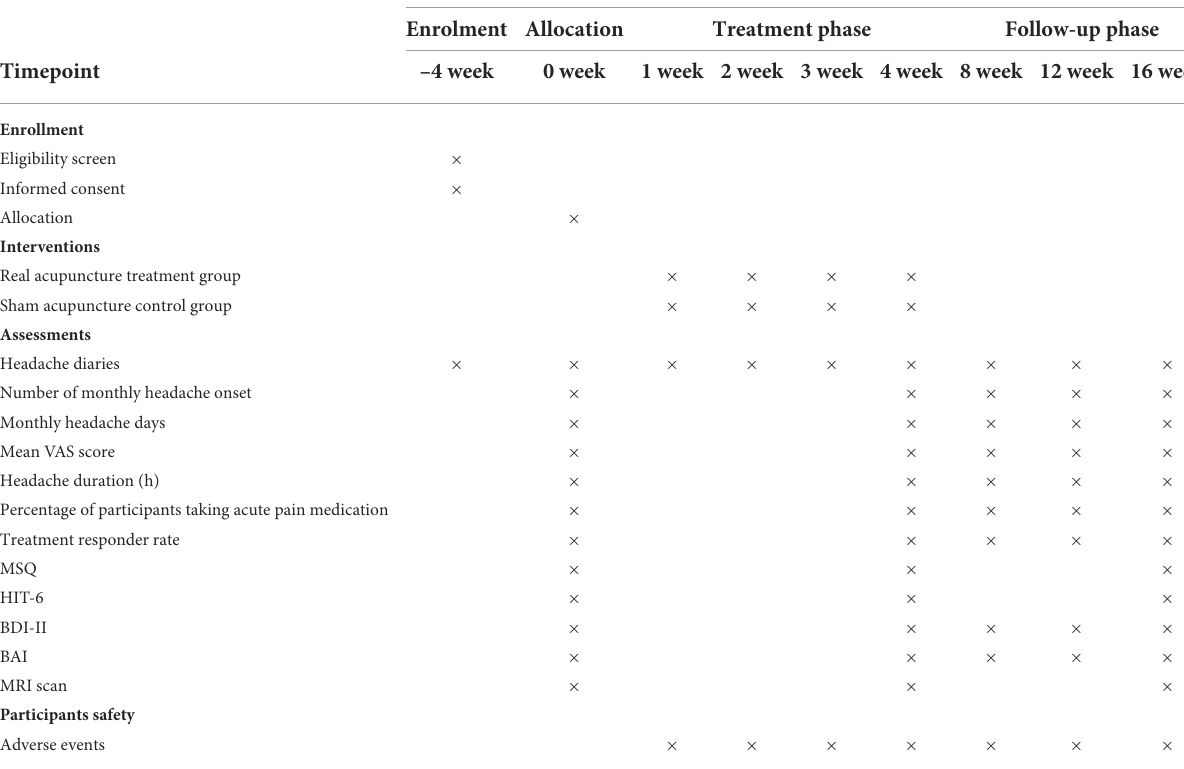
TABLE 1 The enrolment schedules, interventions, and